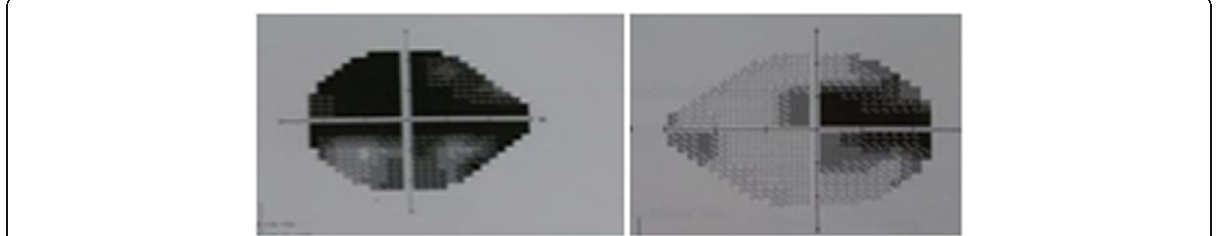
Fig. 2 Visual field defect of the same patient. He was operated through unilateral sub-frontal approach and his data were collected and